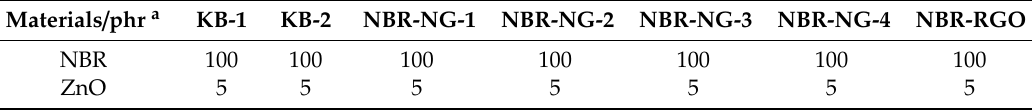
Table 1. Basic formulation of nitrile–butadiene rubber (NBR)